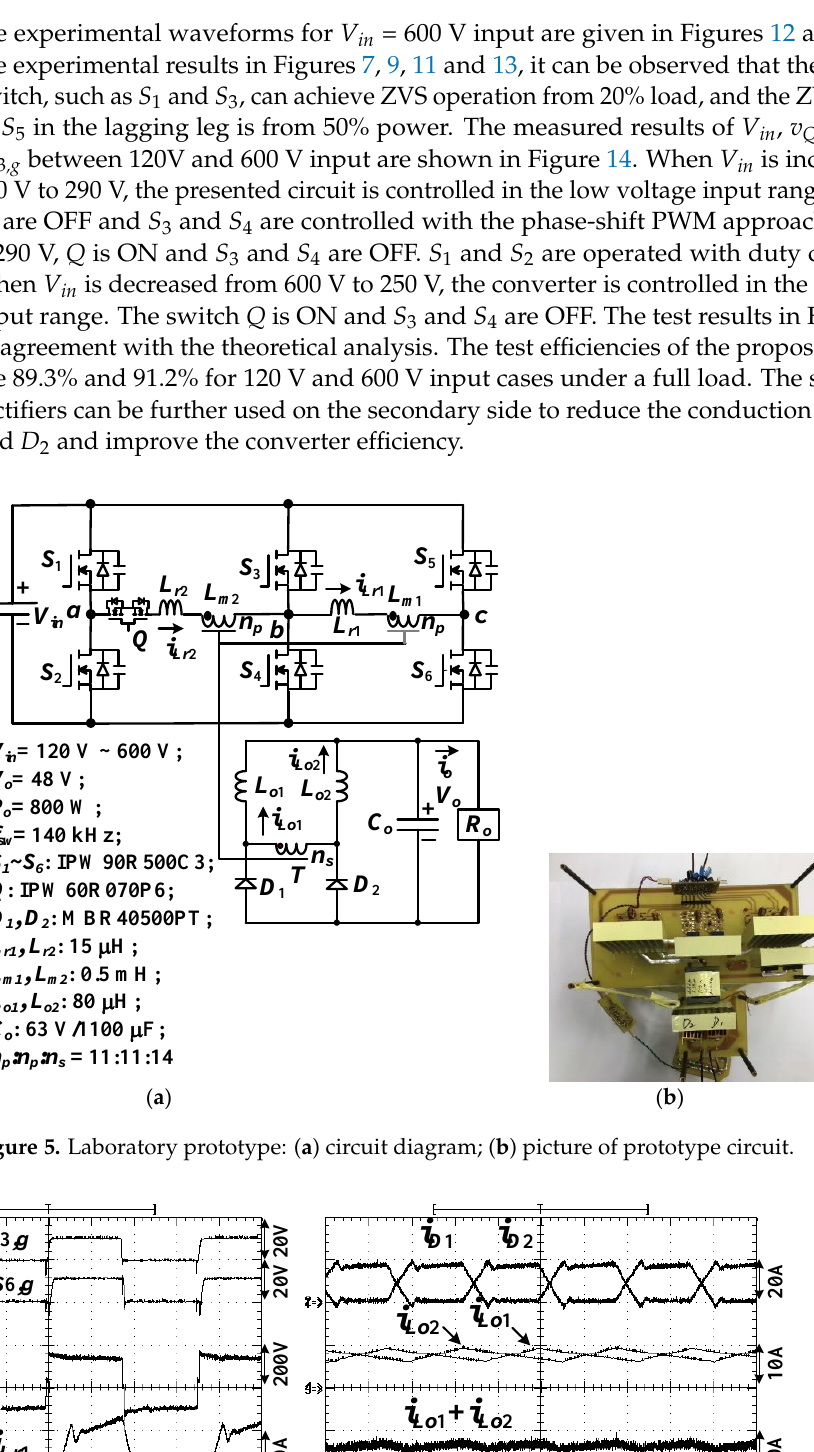
Figure 6. Test waveforms at V in = 120 V (low voltage input range) and P o = 800 W: ( a ) primary-side waveforms v S 3 ,g , v S 5 ,g , v bc , and i Lr 1 ; ( b ) secondary-side waveforms i D 1 , i D 2 , i Lo 1 , i Lo 2 , and i Lo 1 + i Lo 2 .